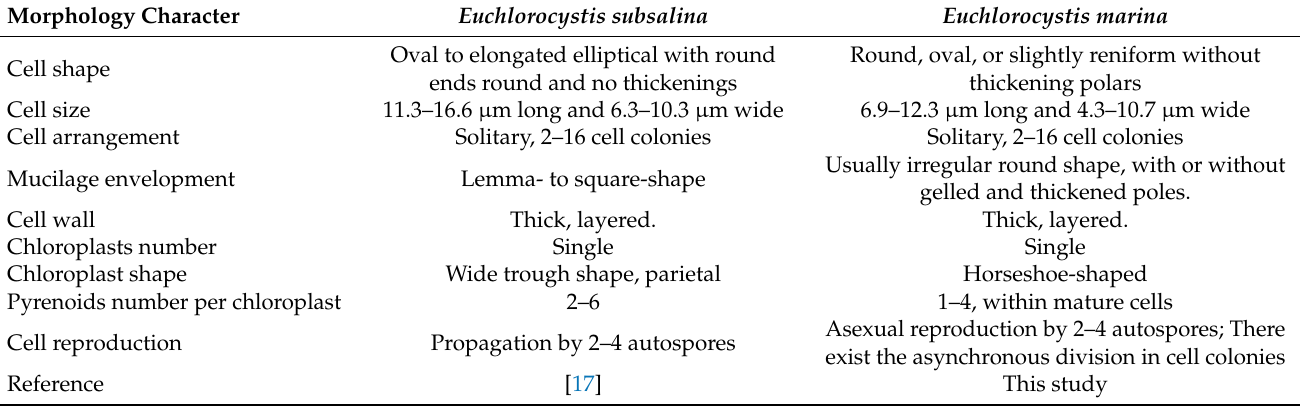
Table 2. Morphological comparison between Euchlorocystis subsalina and Euchlorocystis marina . Morphology Character Euchlorocystis subsalina Euchlorocystis marina Oval to elongated elliptical with round Round, oval, or slightly reniform